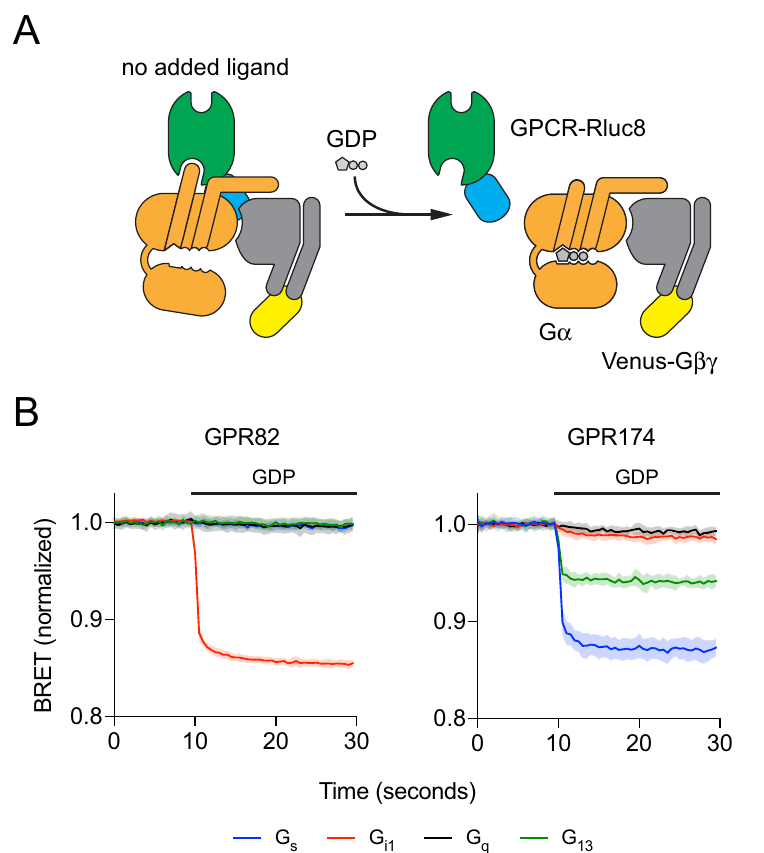
Fig 1. Addition of GDP disrupts GPCR-G protein complexes. (A) Cartoon representation of the experimental design. Constitutively-active GPCRs fused to Renilla luciferase (Rluc8) form spontaneous active-state complexes with nucleotide-free G protein heterotrimers fused (via the G βγ subunit) to the fluorescent protein Venus in the absence of activating ligands. Addition of GDP (100 μ M) disrupts these complexes, decreasing BRET between GPCR-Rluc8 and G αβγ -Venus. (B) Representative experiments of this type with GPR82 and GPR174. Traces represent the mean ± SD of 16 technical replicates from a single experiment, and each trace is normalized to the basal BRET observed for that particular G protein. GDP was injected where indicated by the horizontal